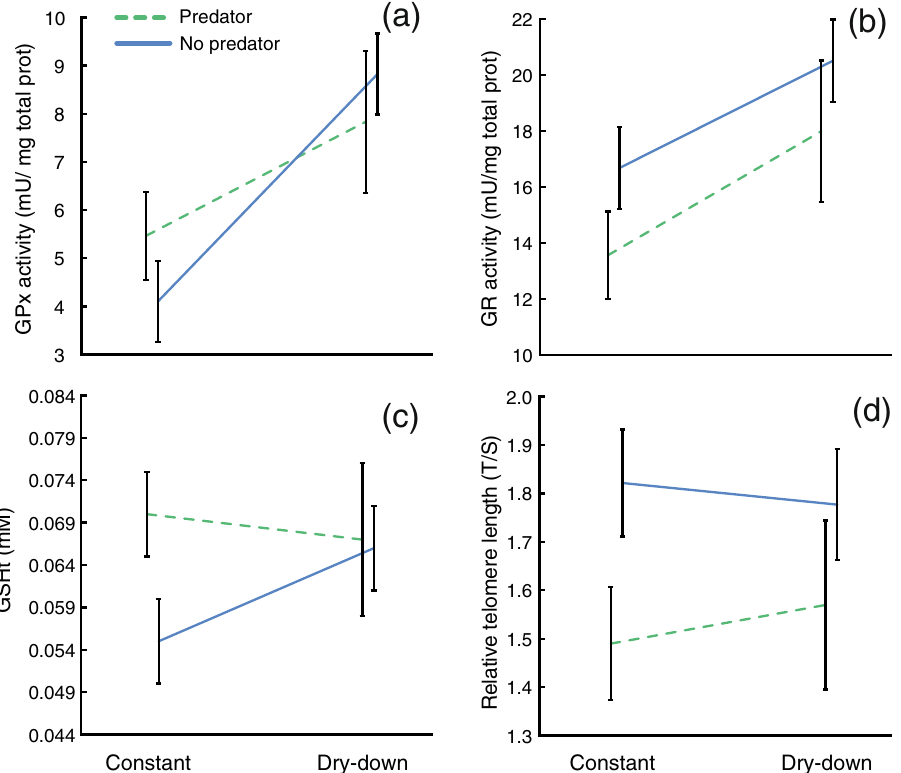
Figure 2. The effect of pond drying and predators on ( a ) glutathione peroxidase (GPx) activity, ( b ) glutathione reductase (GR) activity, ( c ) Total reduced glutathione (GSH t ) level, and ( d ) relative telomere length (T/S) in surviving juveniles of Pelobates cultripes . Data are least square means ± S.E. The water level regime is indicated as ‘Constant’ and ‘Dry-down’ and the lines indicate the presence (P, green dashed line) or absence (NP, blue solid line) of